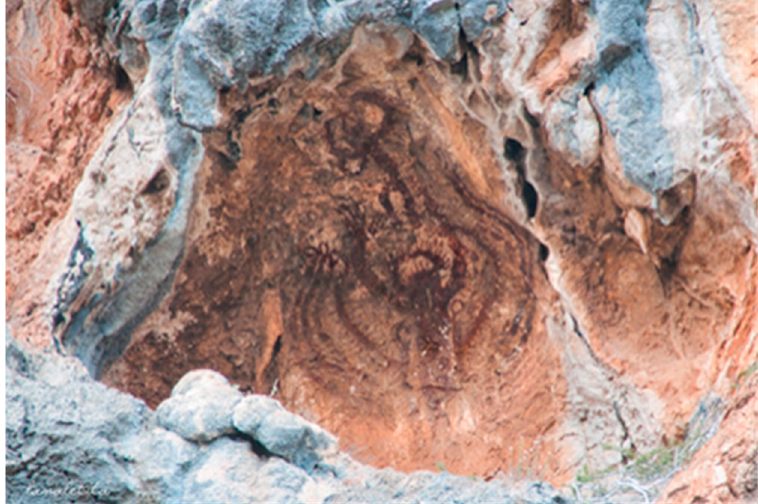
Figure 20. Shelter V. The praying woman in the triangular “tondo”. This photo was taken by the author.